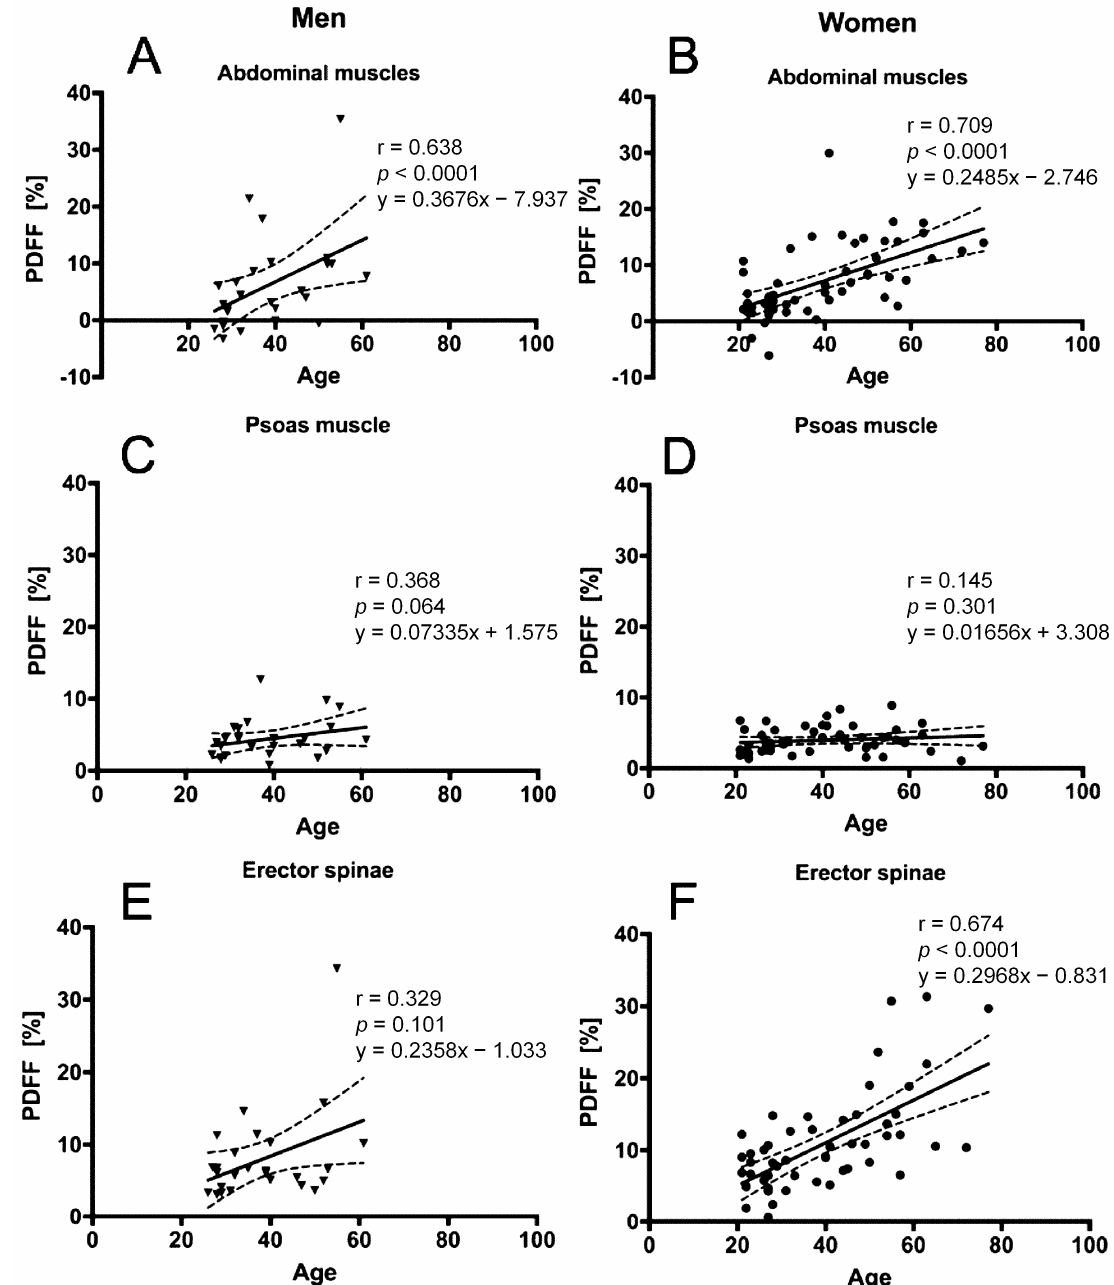
Figure 4. Proton density fat fraction (PDFF) of the abdominal muscle compartments. This figure plots the PDFF of the abdominal muscle, psoas muscle, and erector spinae against age for men ( A , C , E ) and women ( B , D , F ), respectively. The areas between the dotted lines represent the 95% confidence band of the best-fit line. Triangles represent x/y values for men and dots for women.